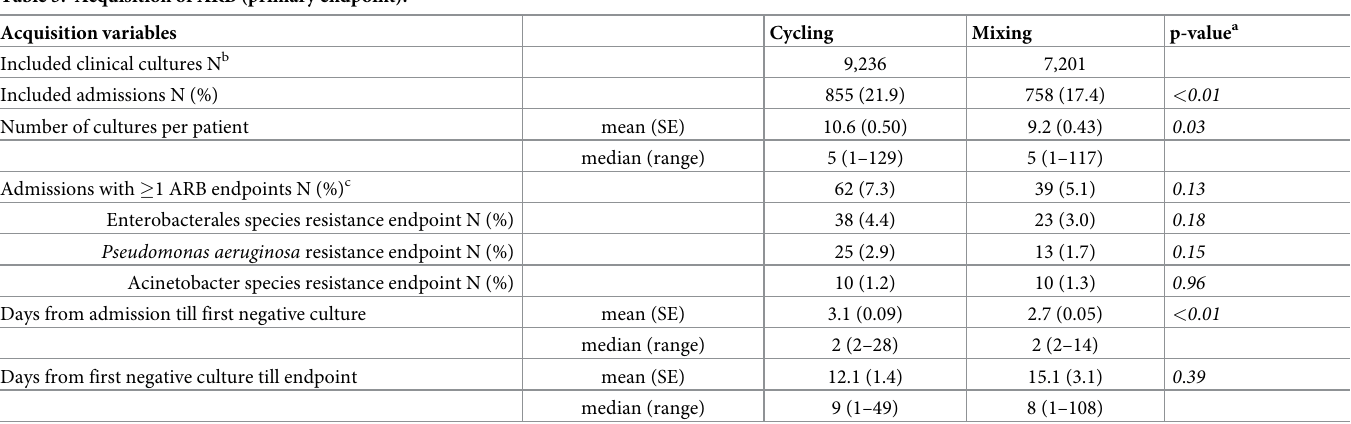
Table 3. Acquisition of ARB (primary endpoint).